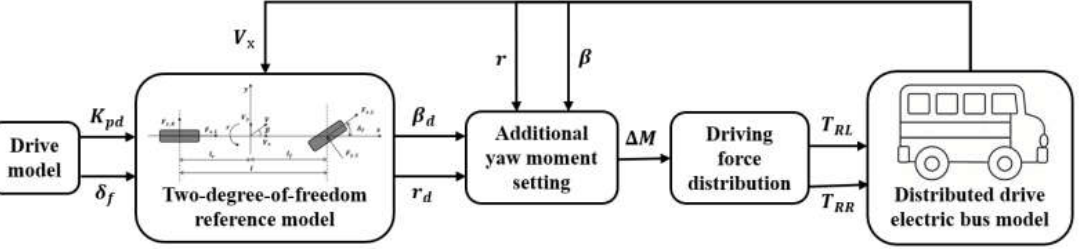
Figure 4. Flowchart of the Total Drive Torque Distribution Control Strategy Based on an Additional Yaw Moment.